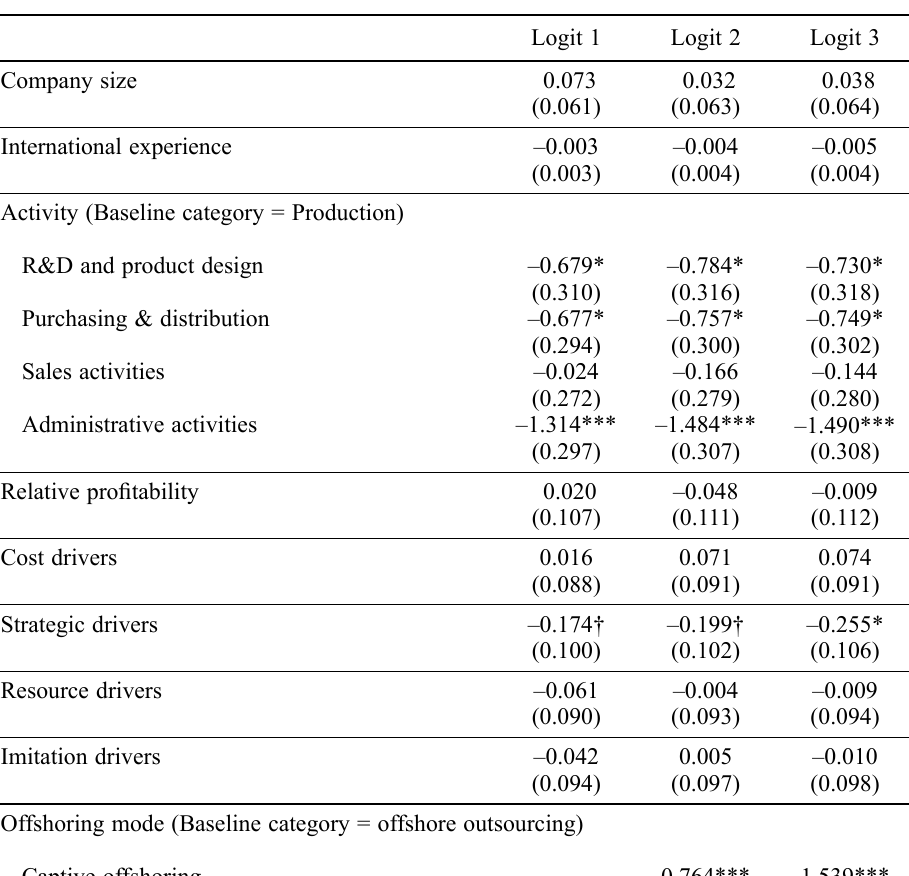
Table 7. Logit regression models (standard errors in